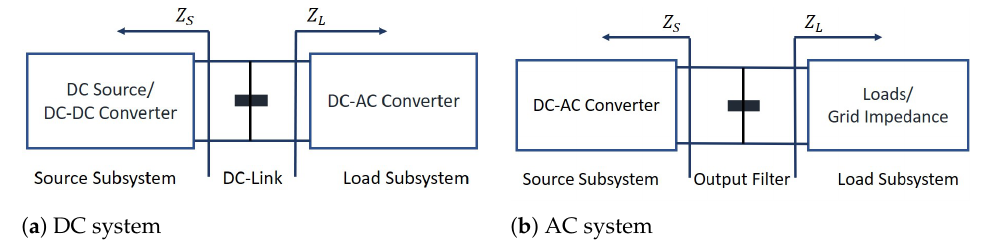
Figure 3. Source-load subsystem model for minor loop gain-based stability